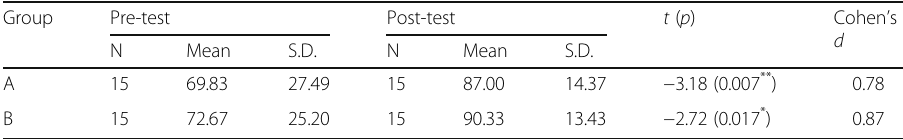
Table 5 The within-group result of t-test in the SFT scores Group